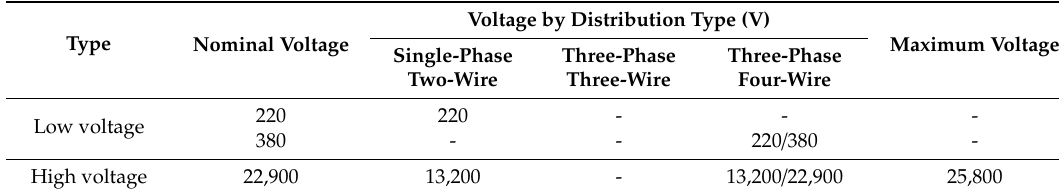
Table 1. The nominal voltage of distribution line.